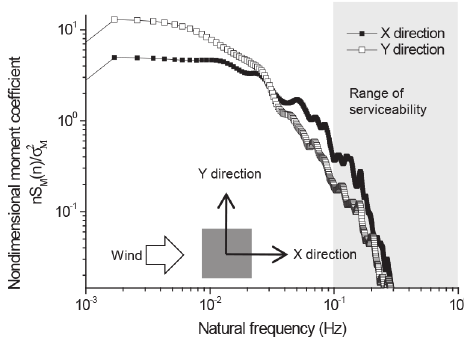
Fig. 1. Typical along-wind and across-wind aerodynamic base moment